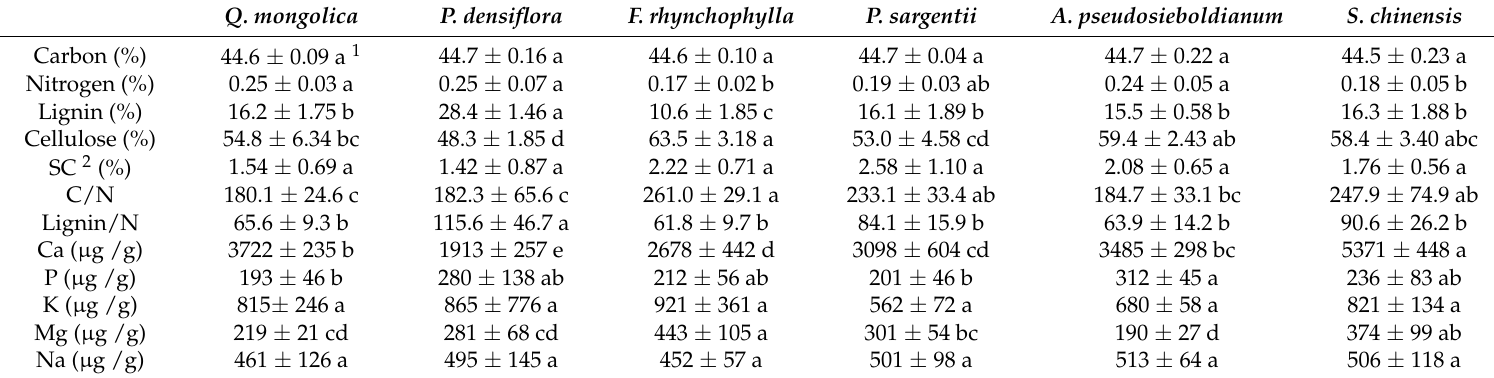
Table 2. Morphological properties of branch wood disk samples for six tree species. Values are means ( n = 5) ±